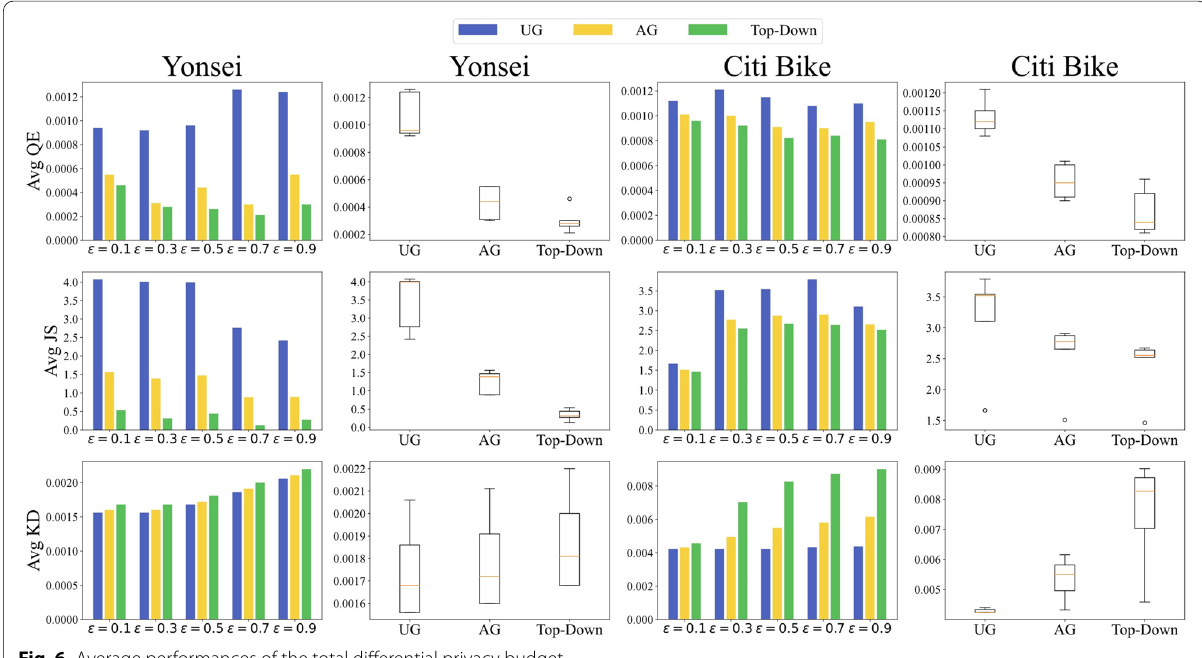
Fig. 6 Average performances of the total differential privacy budget